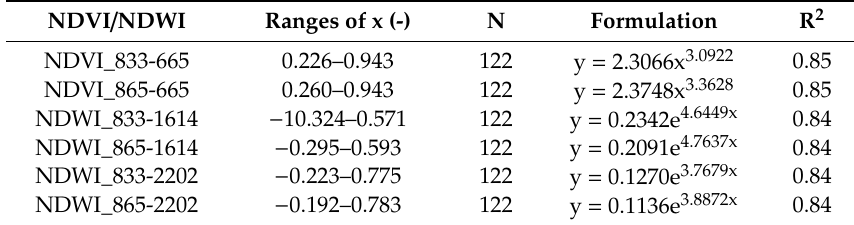
Table 2. Fitted relationships between NDVIs / NDWIs and VWC (y: VWC, x: NDVI / NDWI). Numbers in the NDVIs / NDWIs names denote the center wavelength of the selected bands (in nm). NDVI / NDWI Ranges of x (-) N Formulation R